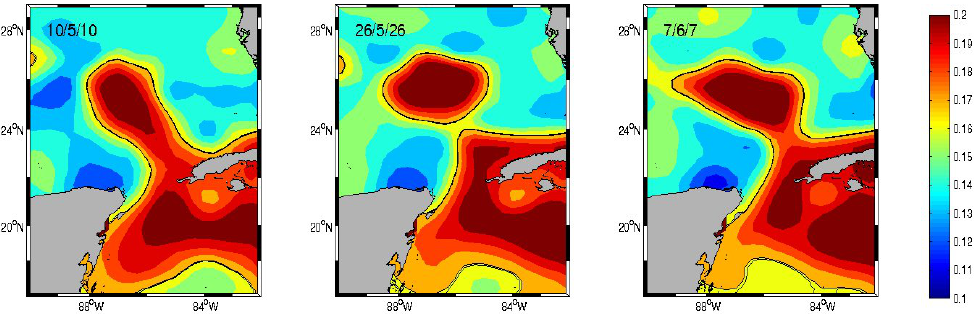
Fig. 2. Weekly snapshots of the SSH field in m for an LCE detachment–reattachment event that occurred in May–June 2008 obtained from